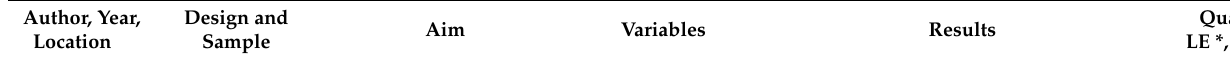
Table 2. Summary of